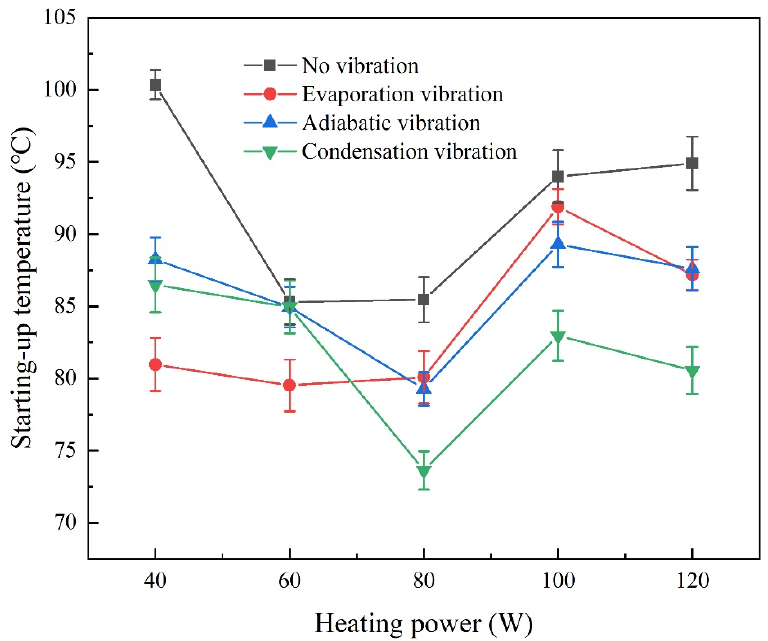
Figure 5. Influence of vibrations at different positions on the starting-up temperature of the PHP under different heating power levels.